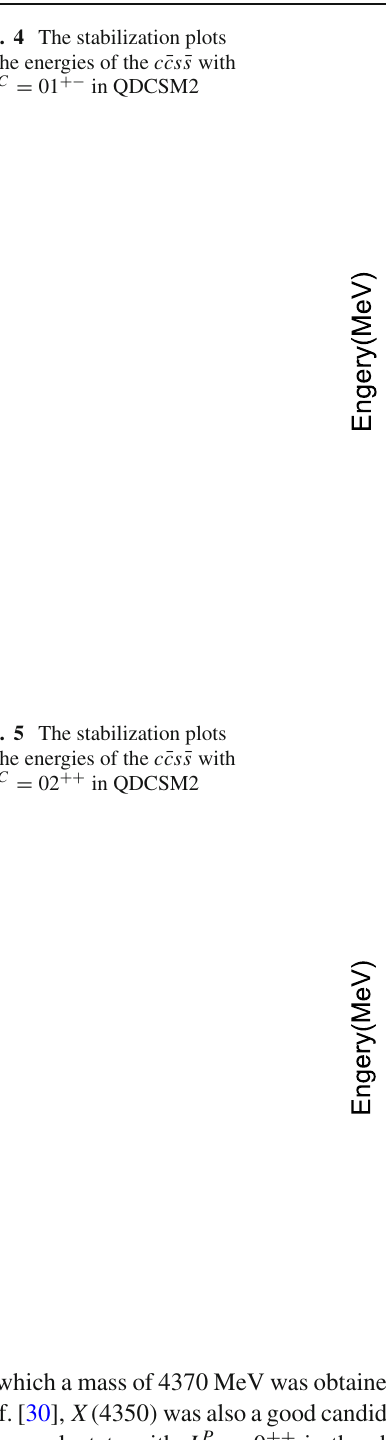
Fig. 4 The stabilization plots of the energies of the c ¯ cs ¯ s with